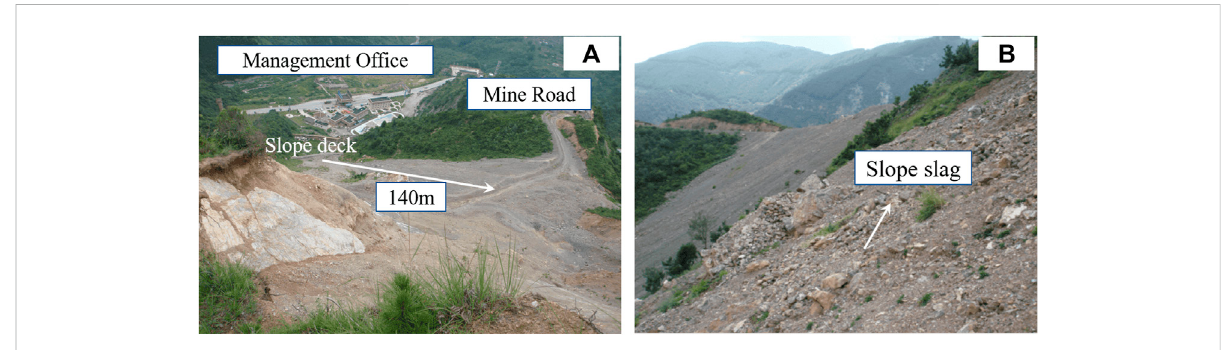
FIGURE 2 Survey on the back hillside of the west exit of the Erlang Mountain Tunnel Management Of fi ce. (A) Geometry of the slope behind the management of fi ce at the west entrance of Erlang Mountain Tunnel and the spatial relationship between the slope and management of fi ce. (B) Slag debris accumulated on the